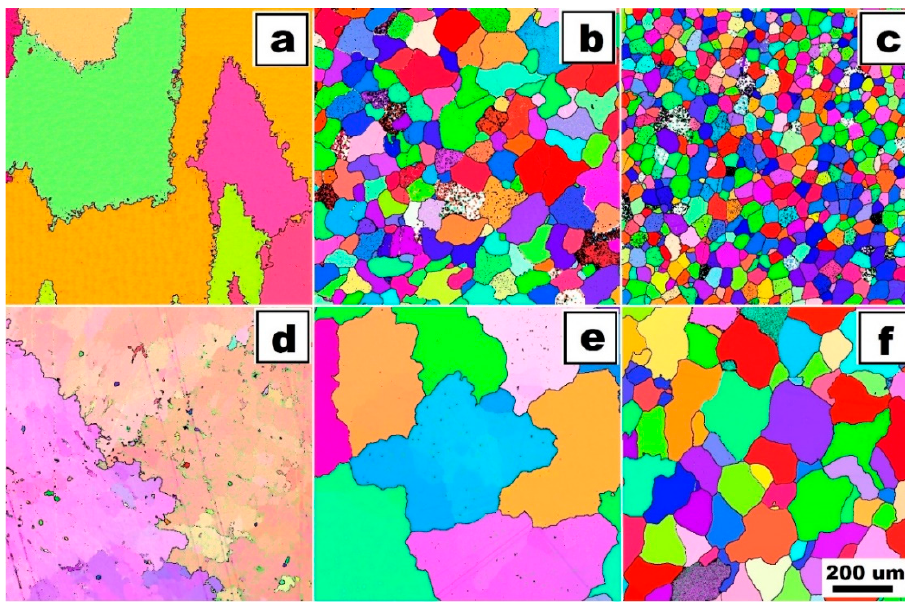
Figure 1. The dimensions of grains of investigated alloys by EBSD: ( a ) Fe28Al5Si as-cast, ( b ) Fe28Al5Si2Mo as-cast, ( c ) Fe28Al5Si2Ti as-cast, ( d ) Fe28Al5Si HT 800/100, ( e ) Fe28Al5Si2Mo HT 800/100, ( f ) Fe28Al5Si2Ti HT 800/100.